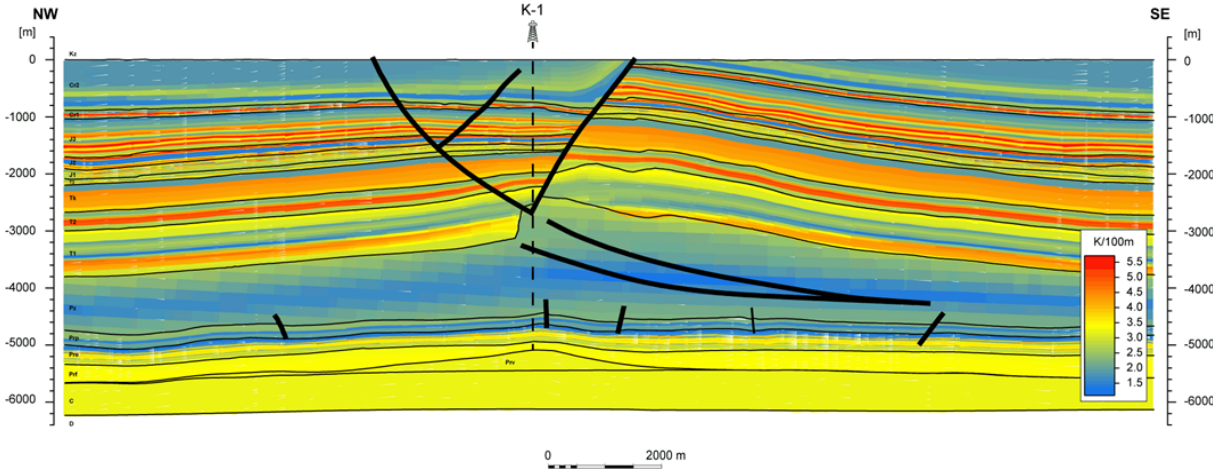
Figure 15. Distribution of the thermal gradient along the NW–SE cross ‐ section (SMV2).